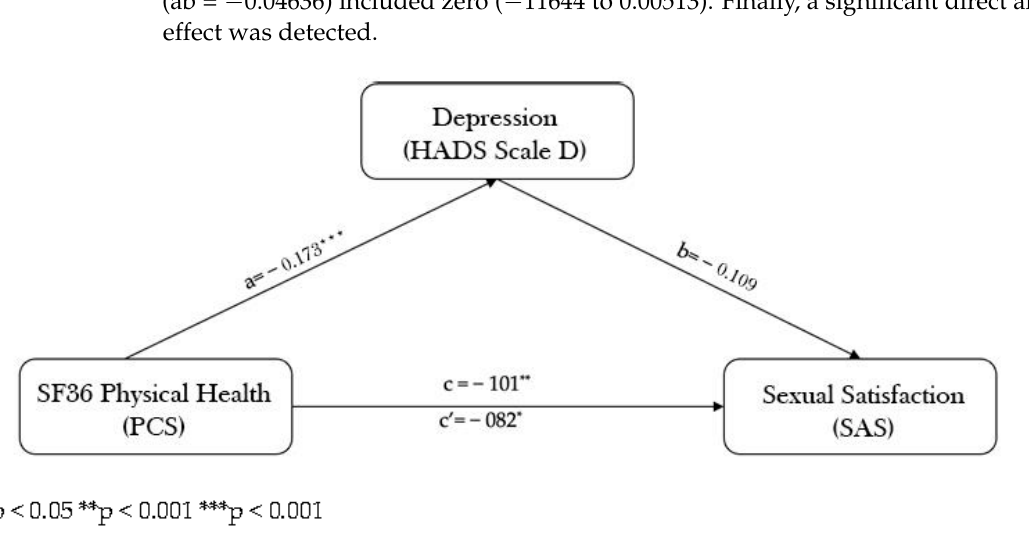
Figure 3. Mediating role of depression.